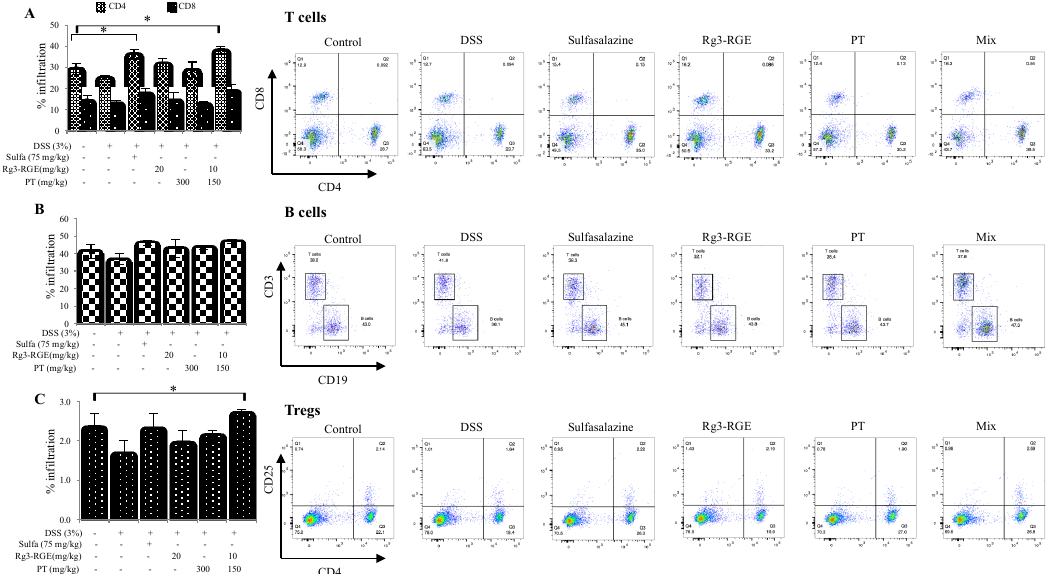
Figure 8. Effects of Rg3-RGE + PT on immune cell subtypes in the spleen. ( A ) Percentage of CD4 + and CD8 + cells, ( B ) CD19 + cells and ( C ) CD4 + CD25 + cells in the spleen. * indicates a significance of p < 0.01 for treatment group when compared to the DSS-treated group. Values in bar graphs represent mean ± SD of four independent experiments. Analysis was conducted on the same day of termination.